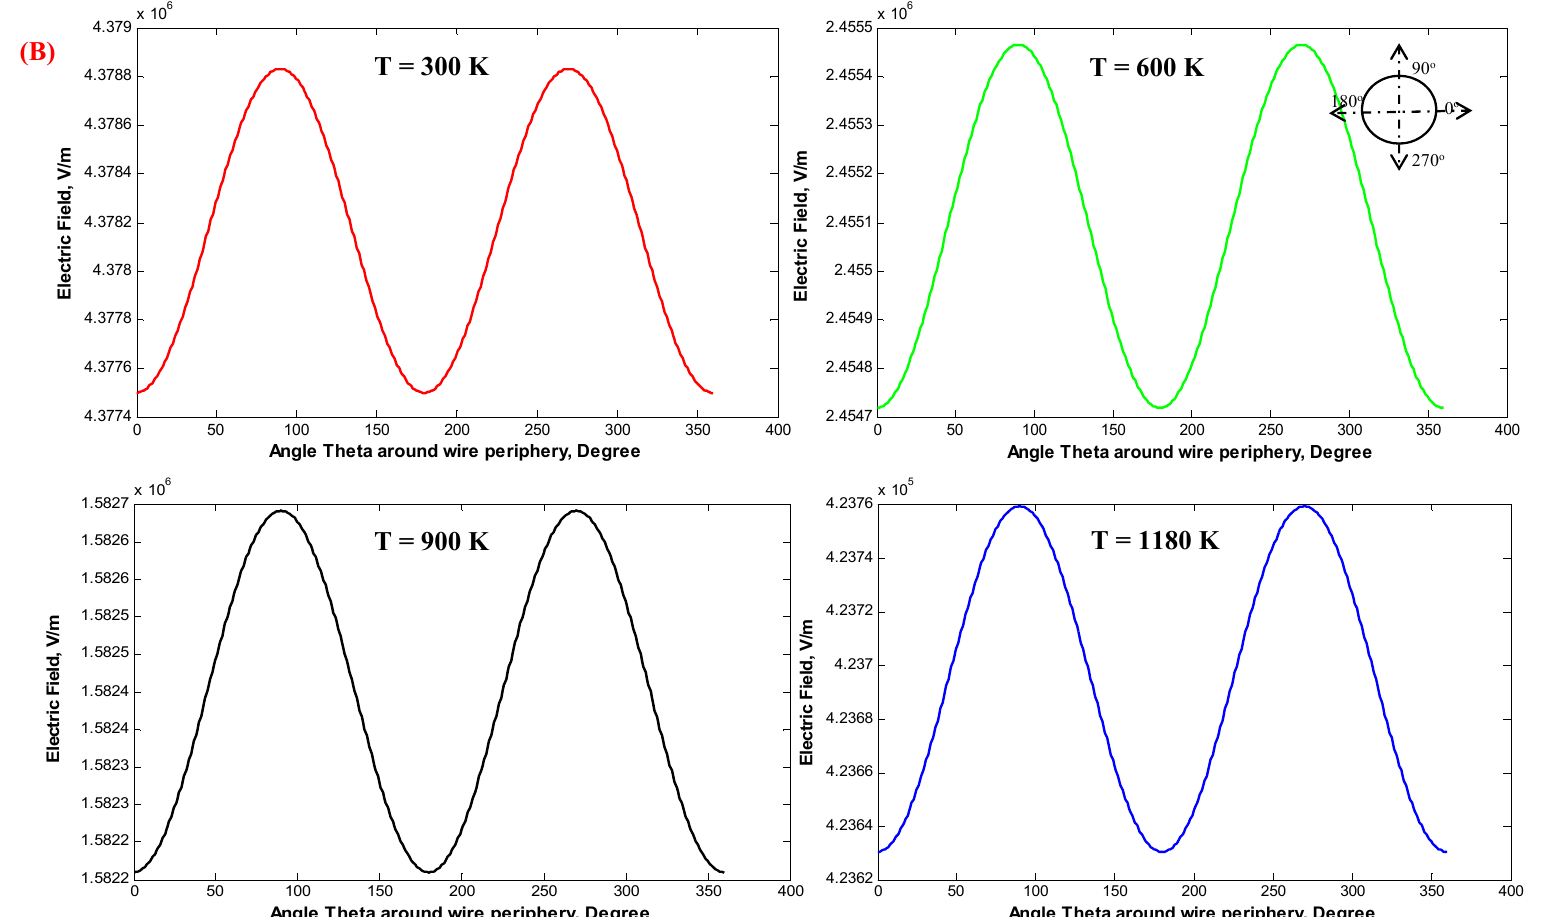
Figure 14. The distribution of the electrostatic field around the stressed discharge wire for the single-wire WDESP: ( A ) r c = 0.26 mm, V o = 14.939 kV; and ( B ) r c = 1.975 mm, V o = 30.868 kV.